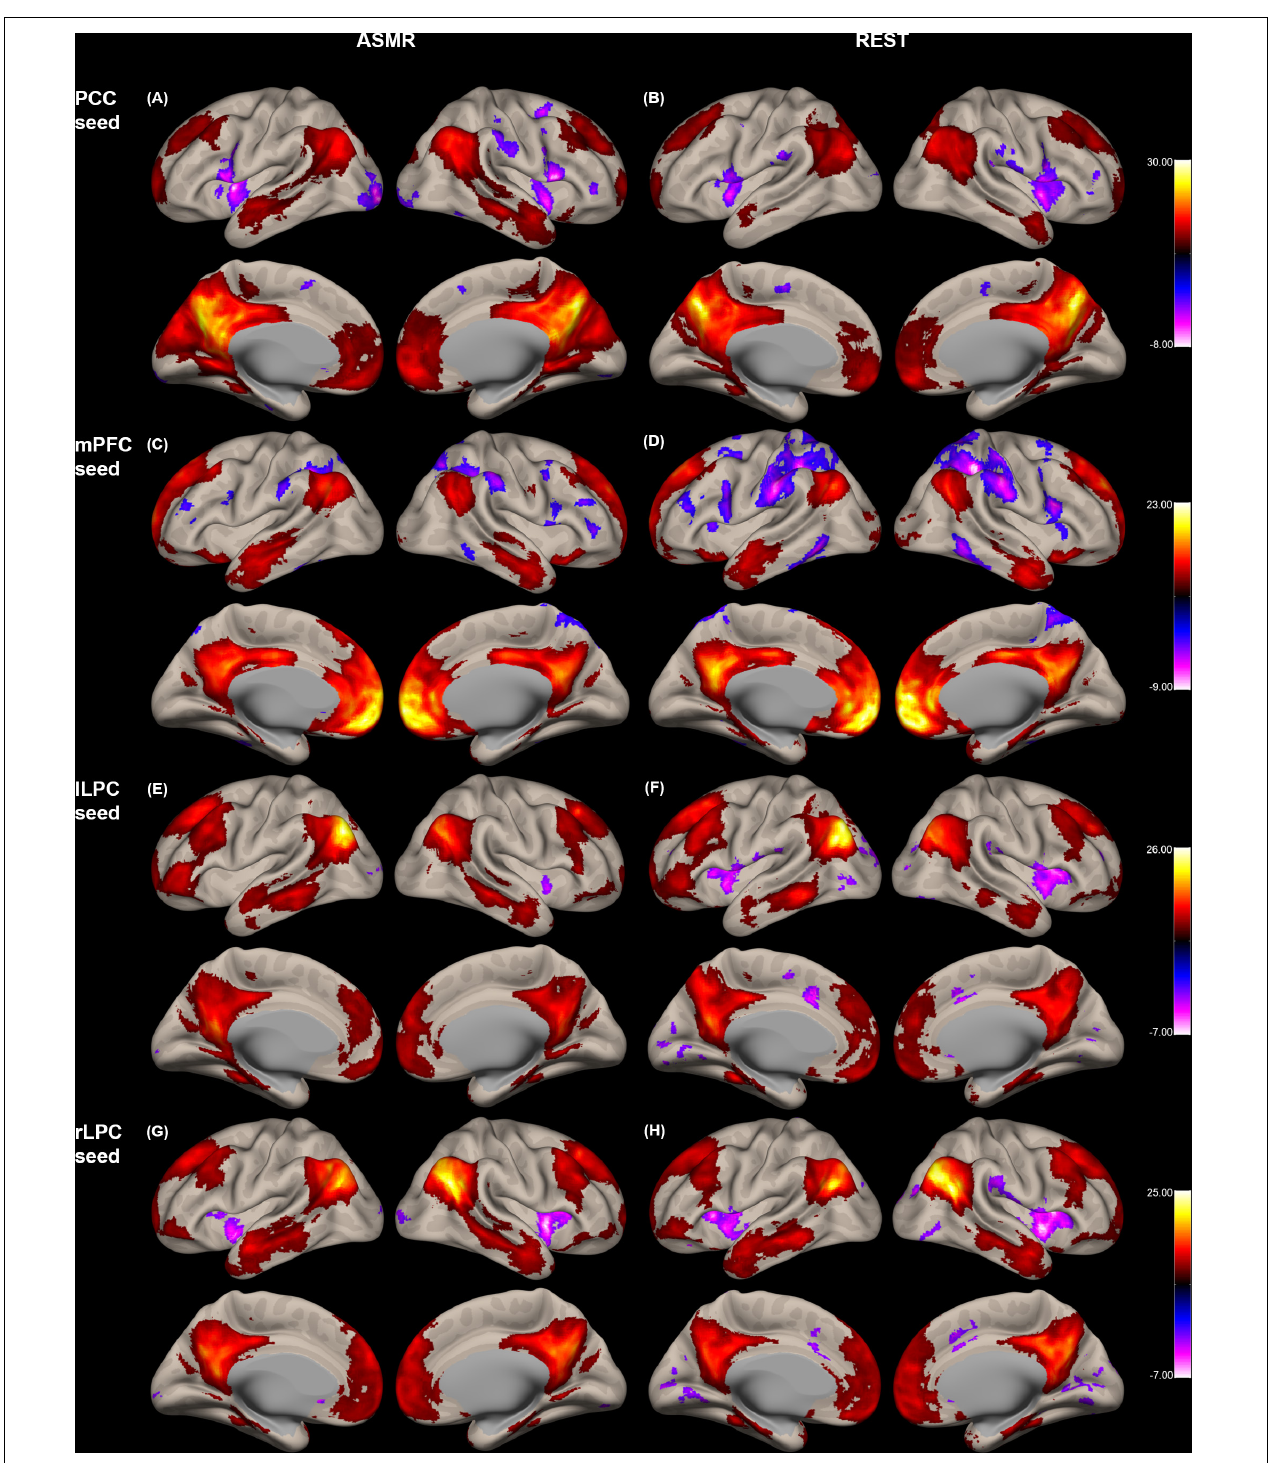
FIGURE 1 | Group-level functional connectivity of the t -statistic in the default mode network during resting-state, and in response to ASMR effects. Functional connectivity strengths in terms of t -statistics were thresholded at a significance level of false discovery rate (FDR)-corrected p < 0.05, and overlaid on a cortical surface atlas. Functional connectivity of the posterior cingulate cortex (PCC) seed region in response to ASMR (A) , and in resting-state (B) . Functional connectivity of the medial prefrontal cortex (mPFC) seed region in response to ASMR (C) , and in resting-state (D) . Functional connectivity of the left lateral parietal cortex (lLPC) seed region in response to ASMR (E) , and in resting-state (F) . Functional connectivity of the right lateral parietal cortex (rLPC) seed region in response to ASMR (G) , and in resting-state (H) .